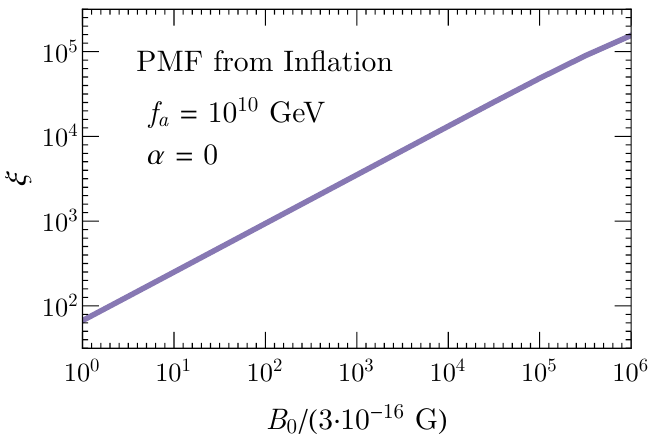
Figure 6 . ξ at T = 1 GeV as a function of B 0 today, scaled by the observed lower bound B inf 3 · 10 − 16 G, for the inflationary PMF, whose coherent length is assumed to be larger than the current Hubble horizon. f is taken to be 10 10 a